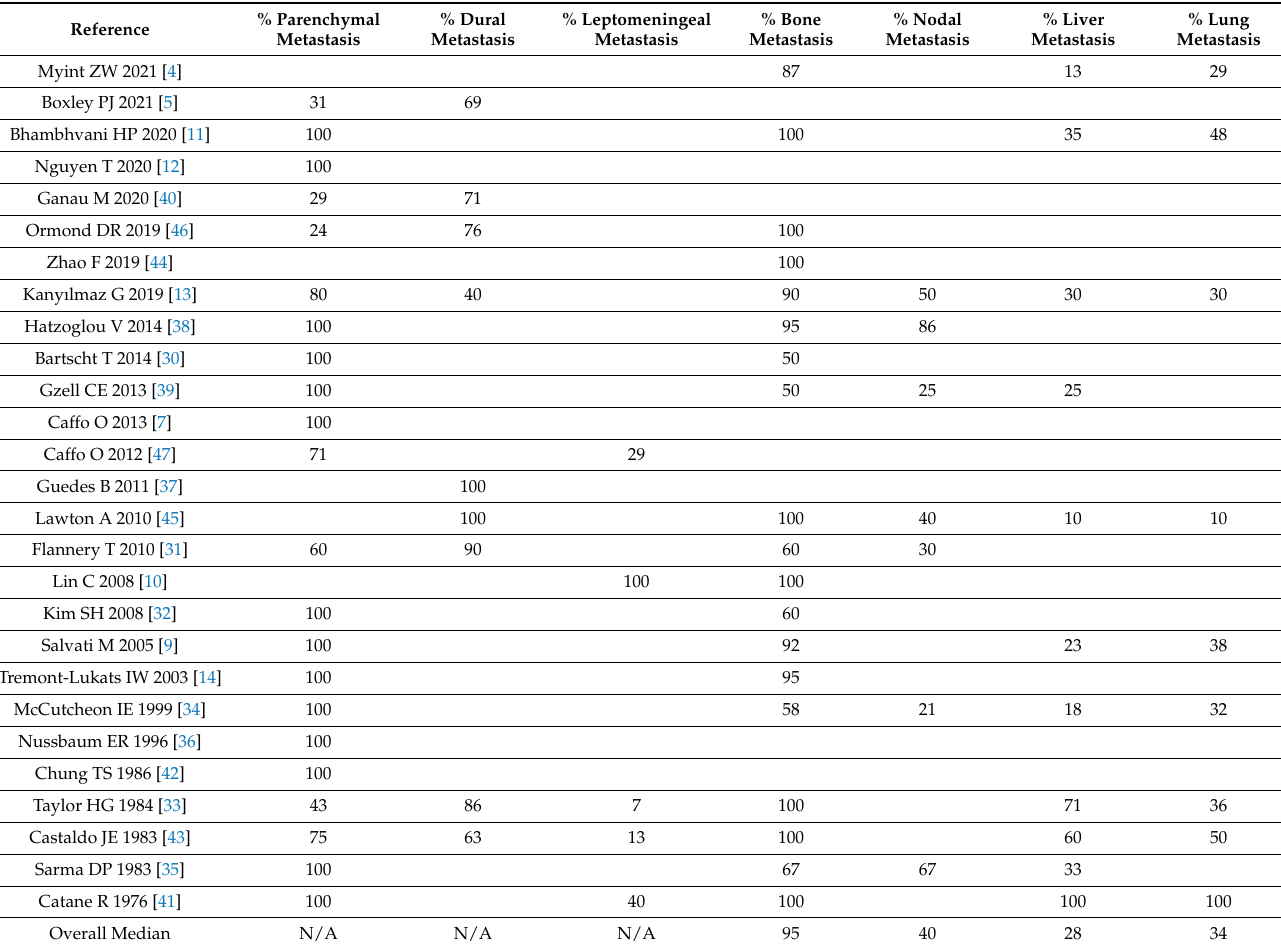
Table 2. Metastatic